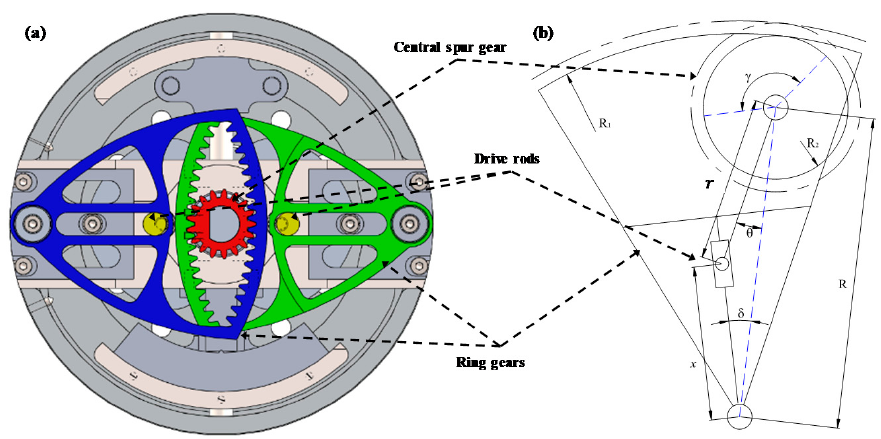
Figure 5. Stiffness adjusting block (SAB) illustration of ( a ) cross section of CAD (computer aided design) model and ( b ) half scheme with a single ring gear.